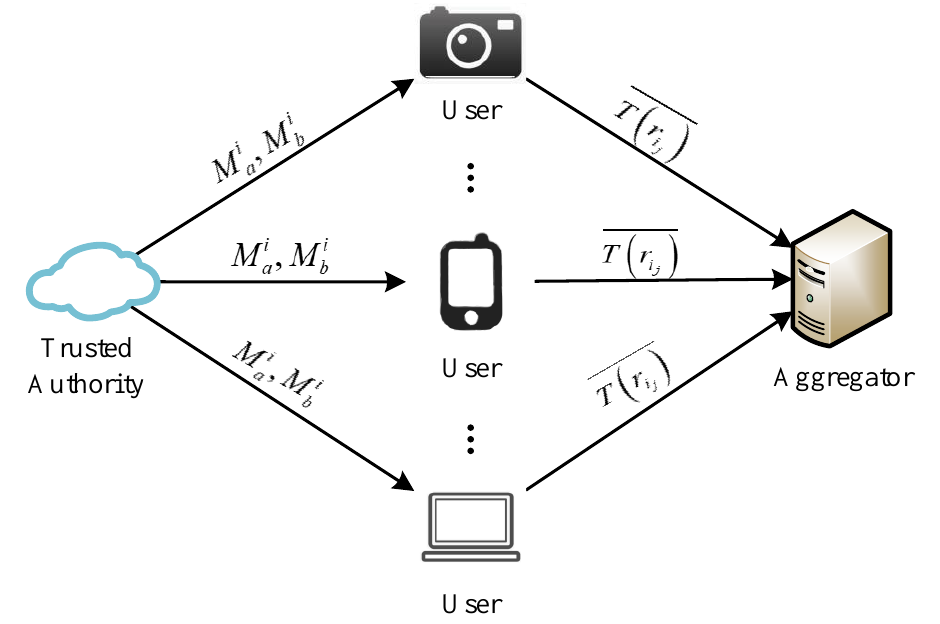
Figure 1. Overview of